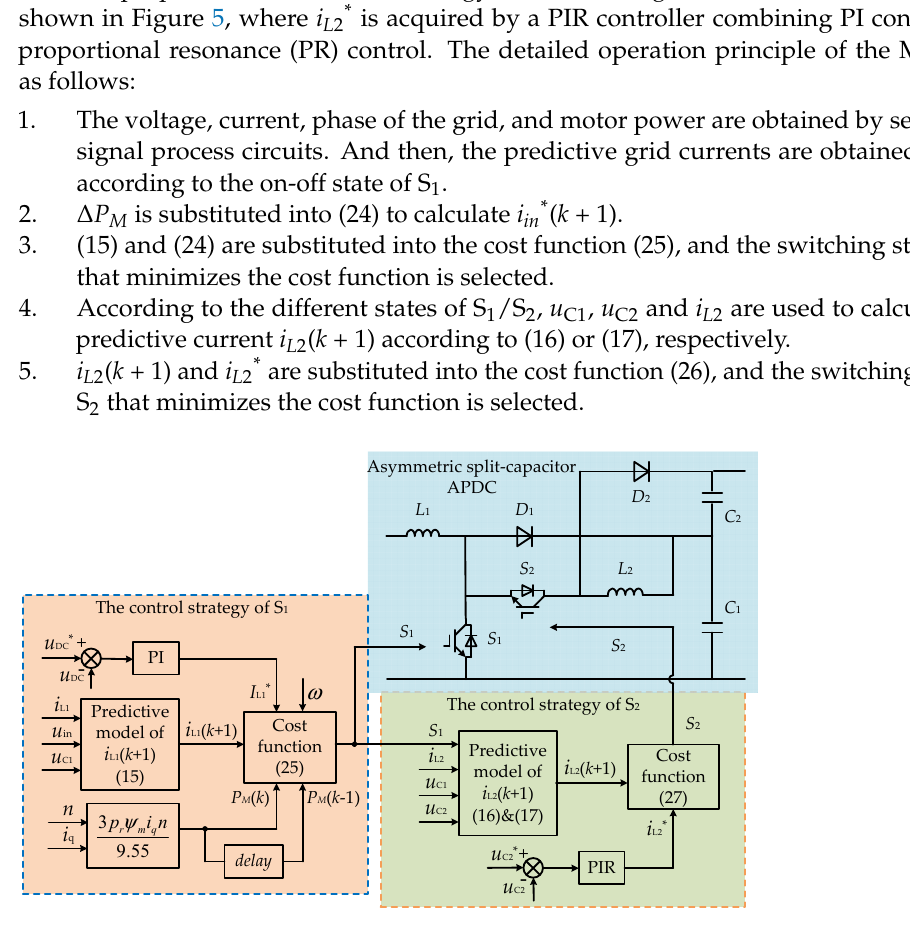
Figure 5. The flow diagram of the MPCC control strategy. 5. Experimental Result To verify the effectiveness of the proposed MPCC, an experimental platform was built, as shown in Figure 6a. The hardware-in-the-loop simulation platform Rtunit was used to implement the control strategy. The key parameters of the ECL drive system are shown in Table 1. A 0.5 kW magnetic powder brake acts as the load. The average grid voltage is 110 V and the angular frequency is 314 rad/s. The DC-link voltage is set to 300 V, the average voltages of C 1 and C 2 are set to 200 V and 100 V, and the maximum voltage ripple is set to 50 V. The speed and torque of PMSM were respectively obtained by